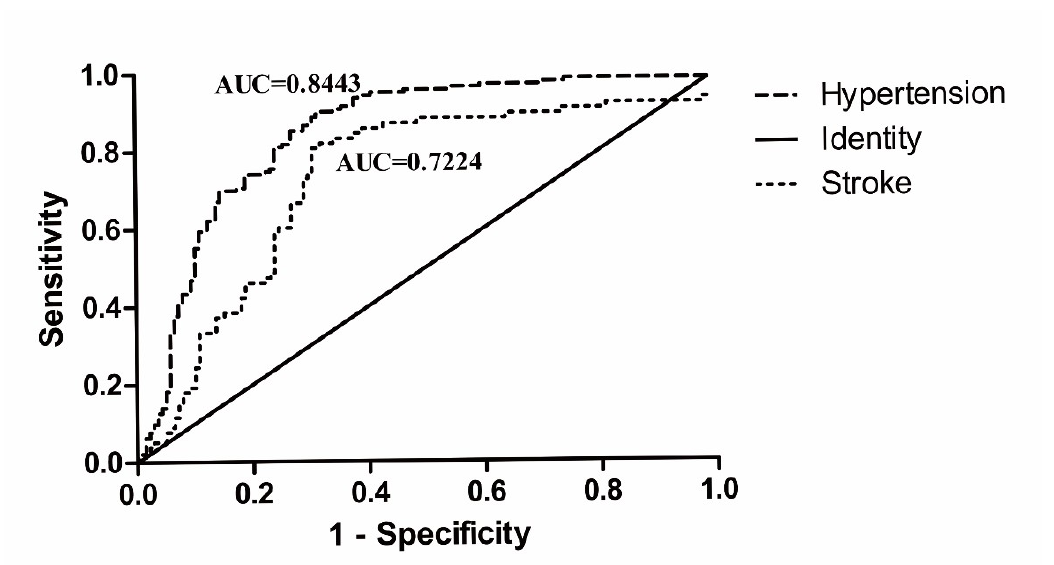
Figure 4 - Receiver operating characteristic (ROC) curve of CBS methylation in male hypertensive and stroke patients.